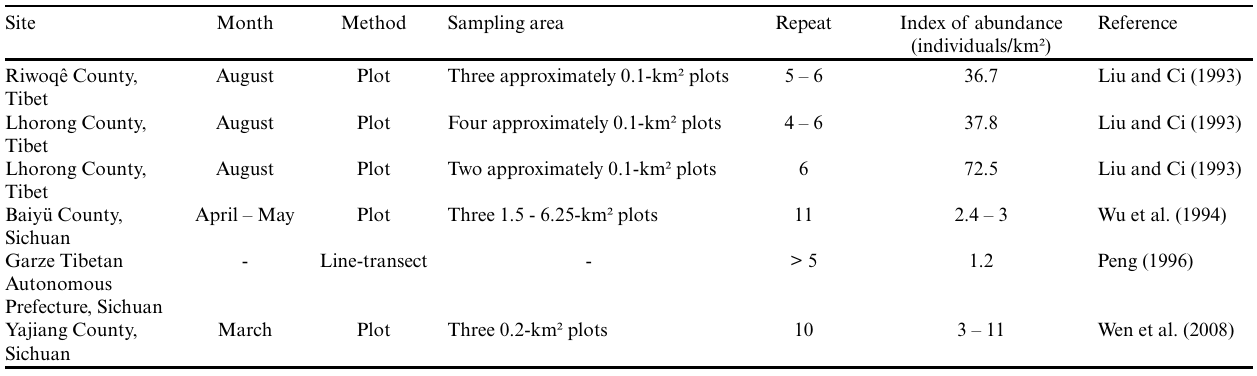
Table 1 . Summary of published studies for estimating index of Buff-throated Partridge ( Tetraophasis szechenyii ) abundance. Site